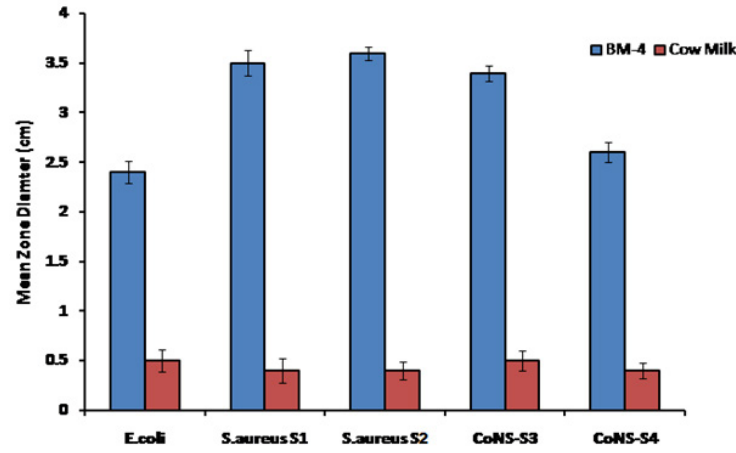
Fig. 1. Mean zone diameters (cm) obtained with breast milk against five test strains